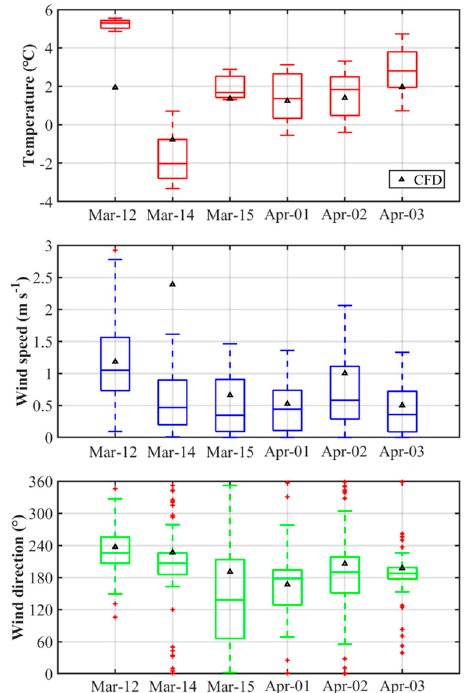
Figure 4. Boxplots of air temperature, wind speed, and wind direction of AWS observation data compared with CFD simulation results at the roadside location of Toegye Intersection. The number of data point is 60 min × 6 days ( n = 360).